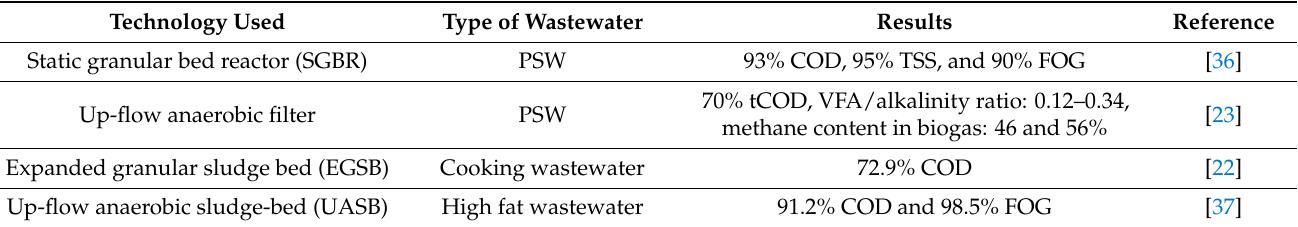
Table 3. Comparison of down-flow expanded granular bed reactor (DEGBR’s) results to other similar wastewater treatment studies. Technology Used Type of Wastewater